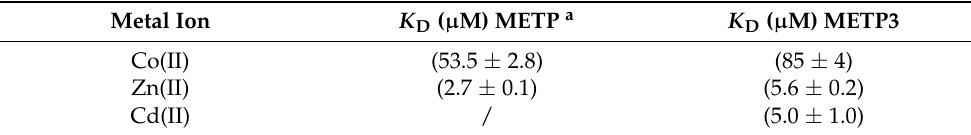
Table 2. K D values for METP and METP3 peptides toward different metal ions.